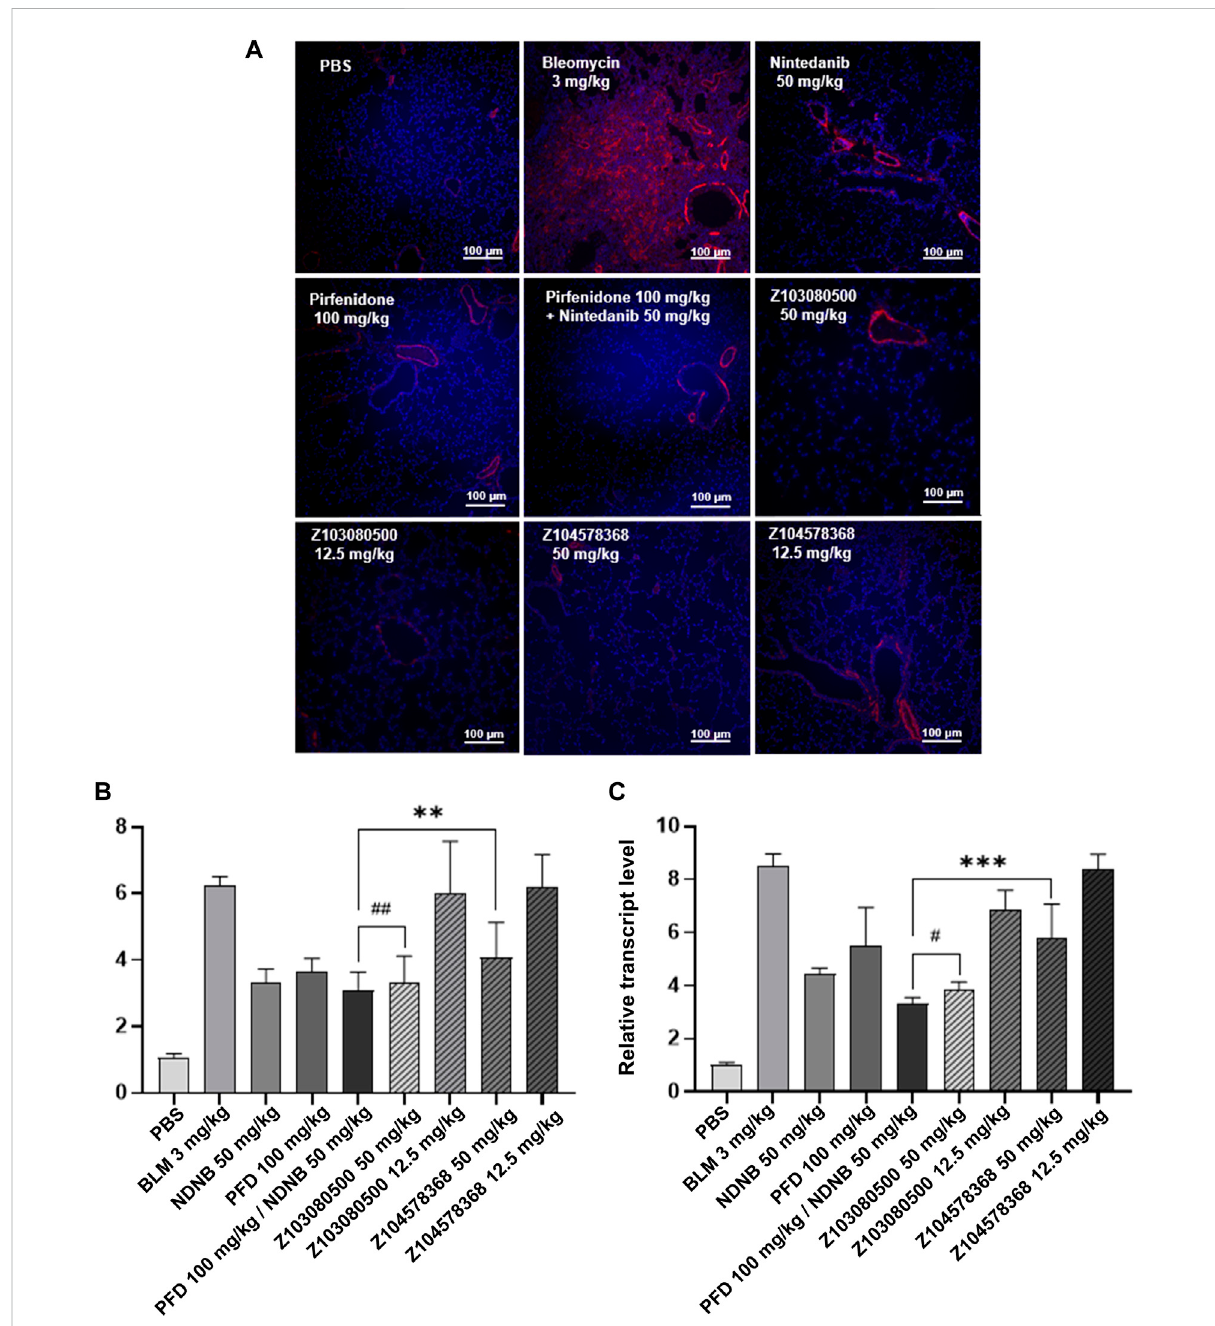
FIGURE 6 Immuno fl uorescent staining and relative transcript levels of in fl ammatory factors. (A) α -SMA immuno fl uorescently stained section. Grouping and doses are marked in the diagram. α -SMA, red. DAPI, blue. (B) Relative transcript level of IFN- γ . (C) Relative transcript level of IL-17. Doses and groups have been marked on the abscissa. All experiments were performed in triplicate independently. α -SMA, Alpha-smooth muscle actin; BLM, BLM; NDNB, NDNB; PFD,